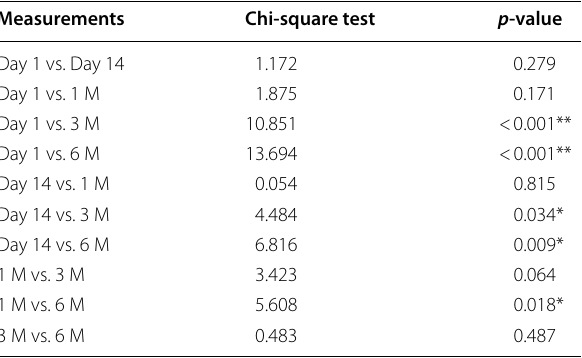
Table 4 Evaluation of neurological deficit progress among study group throughout study